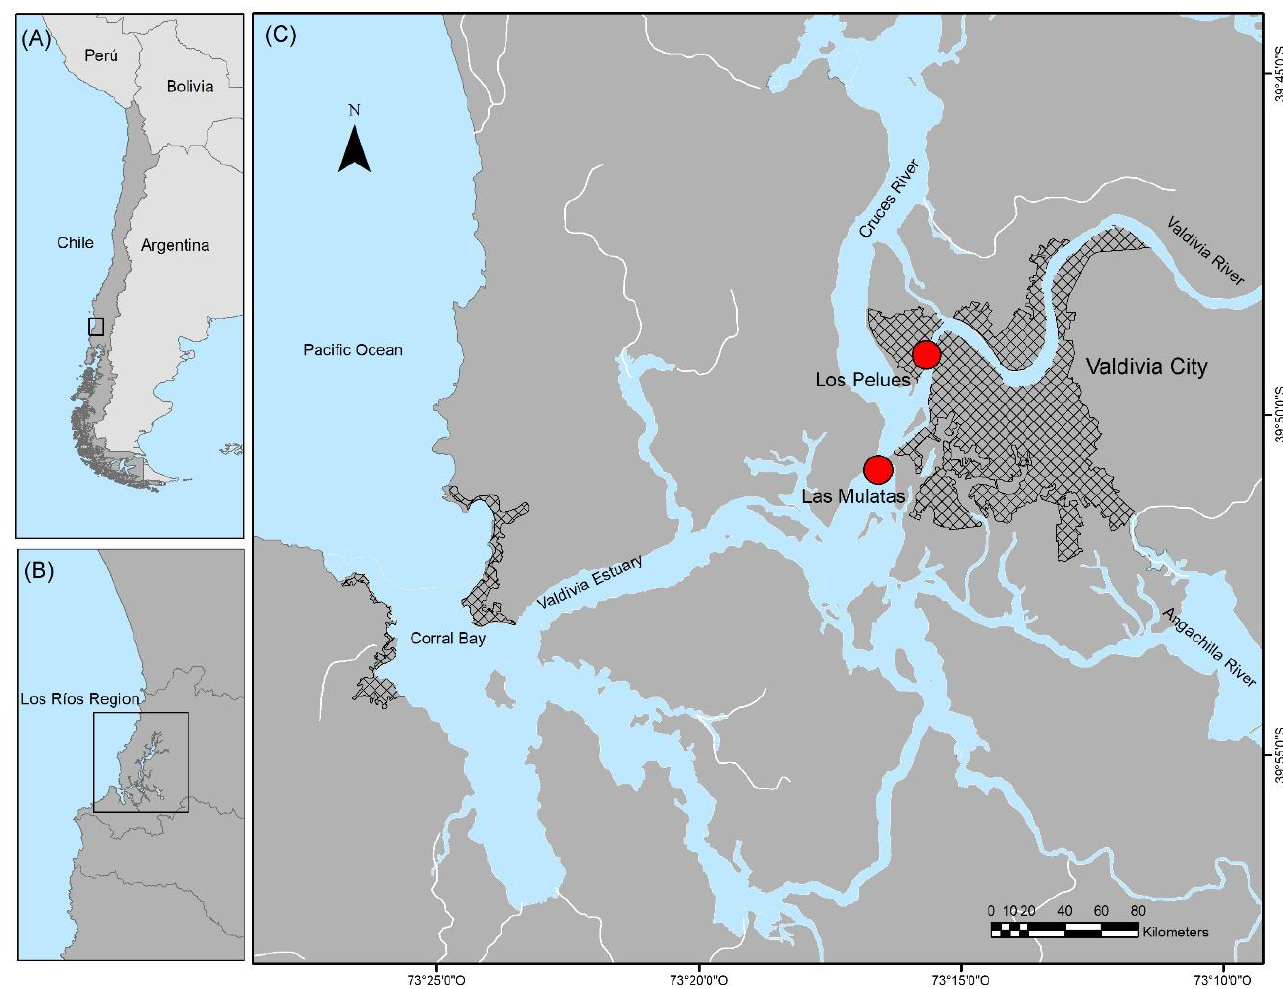
Figure 1. Map of the study area and the two sampling stations for Odontesthes regia , Galaxias maculatus , and water samples of the Valdivia River estuary in southern Chile. ( A , B ) Show the locality in South America and Chile. ( C ) Shows the Valdivia River estuary.